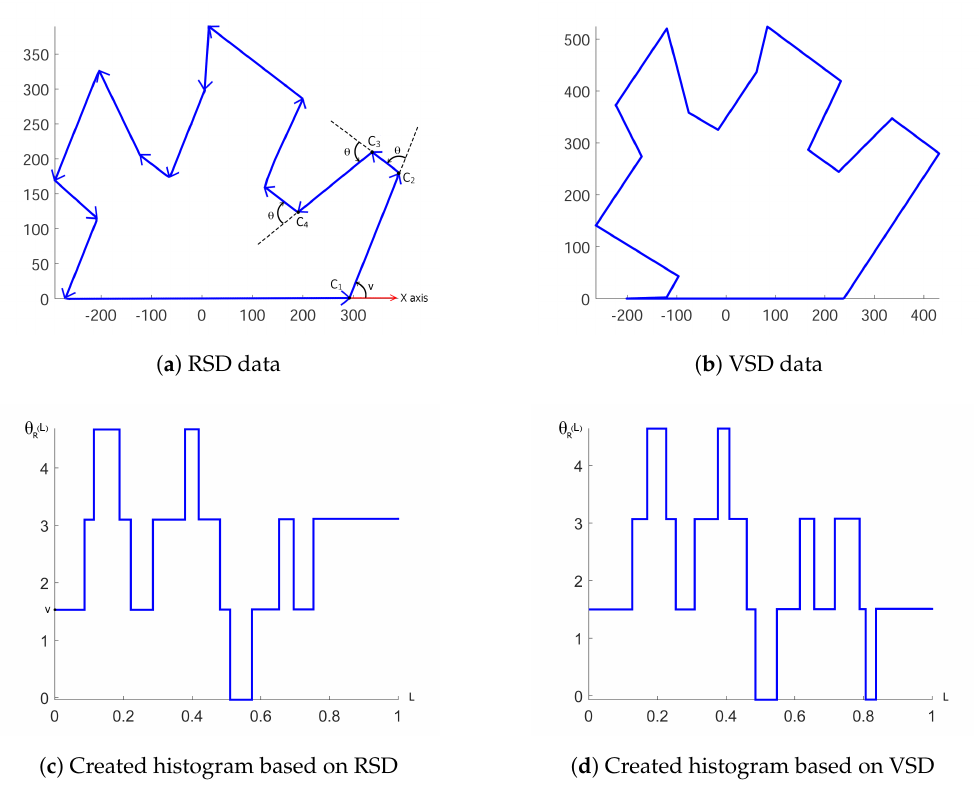
Figure 6. Histogram creation